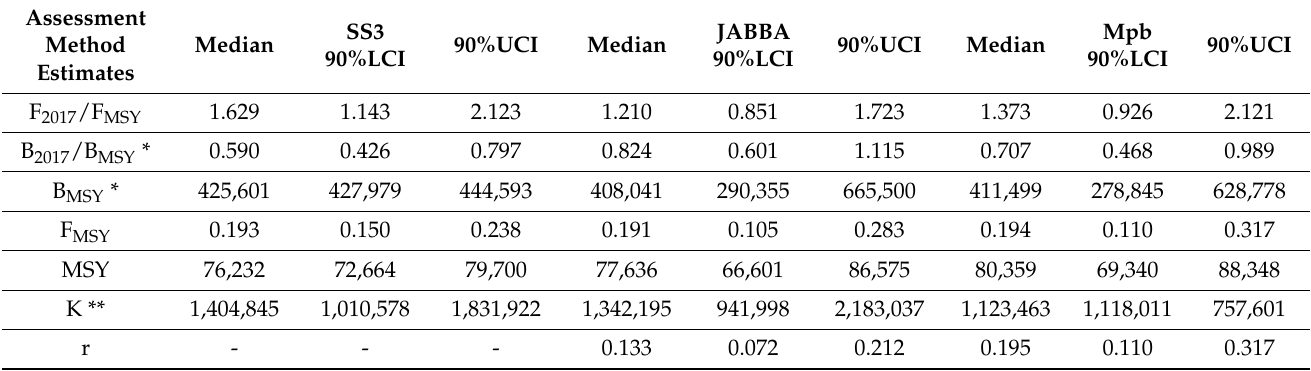
Table 1. Statistics summary of the stock status, benchmarks, and key parameters from the three stock assessment models for Atlantic BET. Reproduced from [29], with permission from International Commission for the Conservation of Atlantic Tunas,